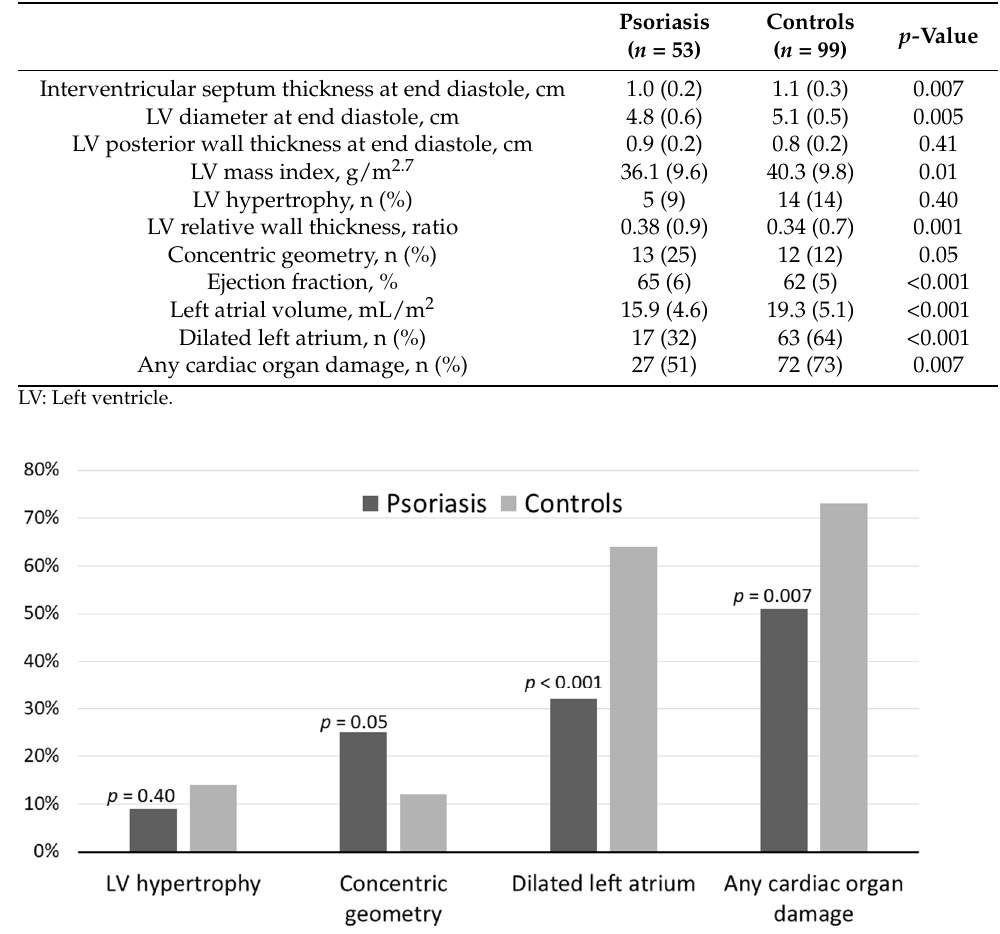
Table 2. Echocardiographic findings in psoriasis patients and controls.